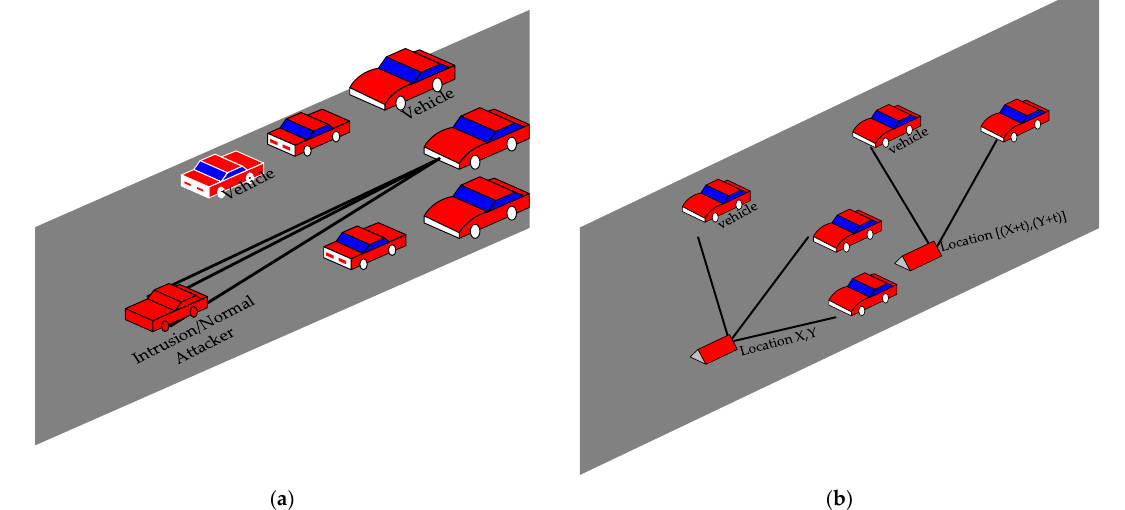
Figure 3. ( a ) Normal intrusion / attacker; ( b ) Smart intrusion /